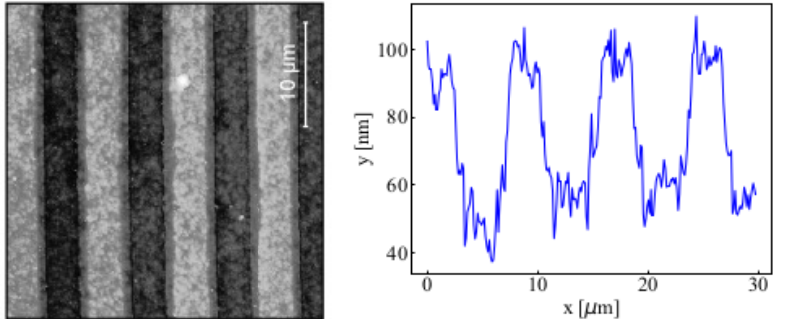
Figure 2. An electron microscope photography of etched sample ( left ) with a corresponding AFM profile ( right ); x and y coordinates describe, respectively, position of the tip of AFM in the plane of the sample and in the direction normal to this